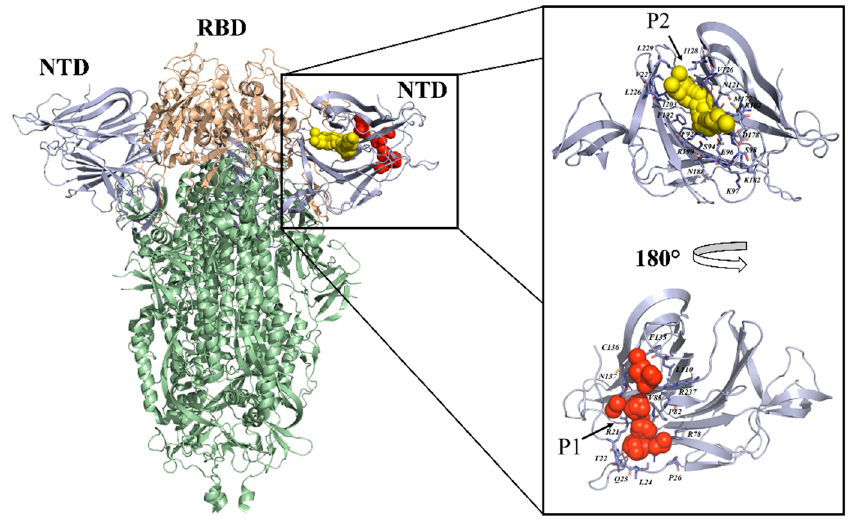
Figure 1. Cryo ‐ EM structure of the SARS ‐ CoV ‐ 2 spike (S) glycoprotein (PDB code: 7JJI [42]) em ‐ ployed for the performed cavity mapping. The protein is rendered as cartoon, important residues forming the druggable cavities P1 (red spheres) and P2 (yellow spheres) identified by SiteMap [41] are rendered as sticks in the zoomed inset.